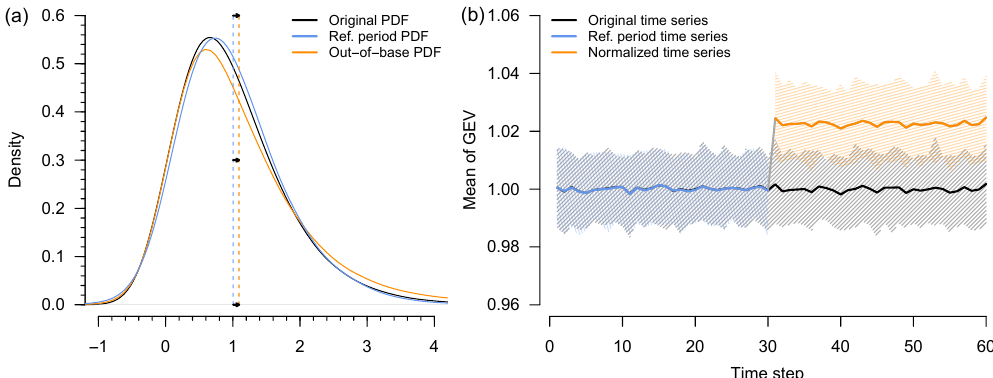
Figure 1. Conceptual example of biases in the mean induced by normalization based on a fixed reference period. (a) Probability distributions and their respective means for an artificial dataset of 10 4 grid cells each comprised of random variables sampled from a generalized extreme value distribution (GEV; µ = 1, σ = 1, ξ = 0, sample size n ref = 8 for illustration) distribution, and normalized following Donat et al. (2016) with different reference periods. (b) Shift in the mean of spatially aggregated variables due to reference period normalization ( n ref = 30 following Donat et al., 2016, confidence intervals denote the 5th to 95th percentile). Code to reproduce this example is provided in the